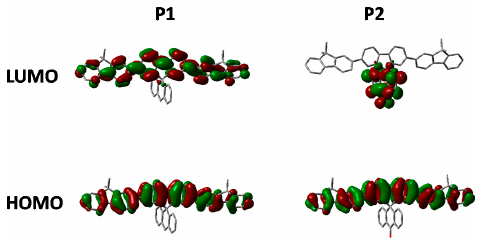
Figure 5. HOMO and LUMO orbitals of P1 and P2 (DFT B3LYP/6-31G* isovalue